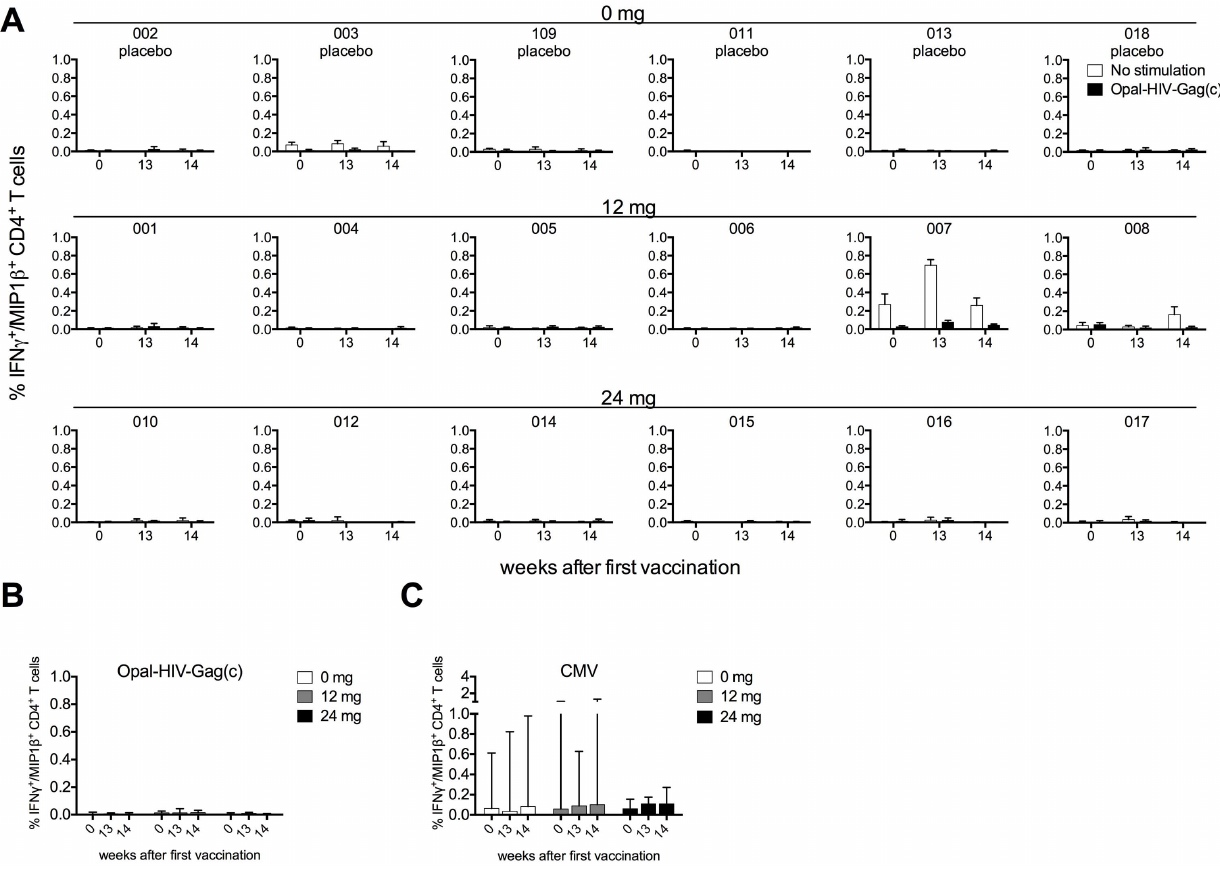
Figure 5. OPAL-HIV-Gag(c) and CMV peptide pool specific CD4 + T-cell responses before and after vaccination. All six subjects from each dose group (0 mg, 12 mg and 24 mg) were tested for OPAL-HIV-Gag(c) specific or no peptide (mock) responses by ICS shown as IFN c + /MIP1 b + double positive CD4 + T-cells processed from frozen PBMCs derived at week 0, 13 and 14 after first vaccination expressed as the mean of triplicate stimulations (A) and expressed as median values within dose groups with error bars representing inter quartile ranges for OPAL-HIV-Gag(c) (B) and for CMV specific CD4 + T-cell responses (C).